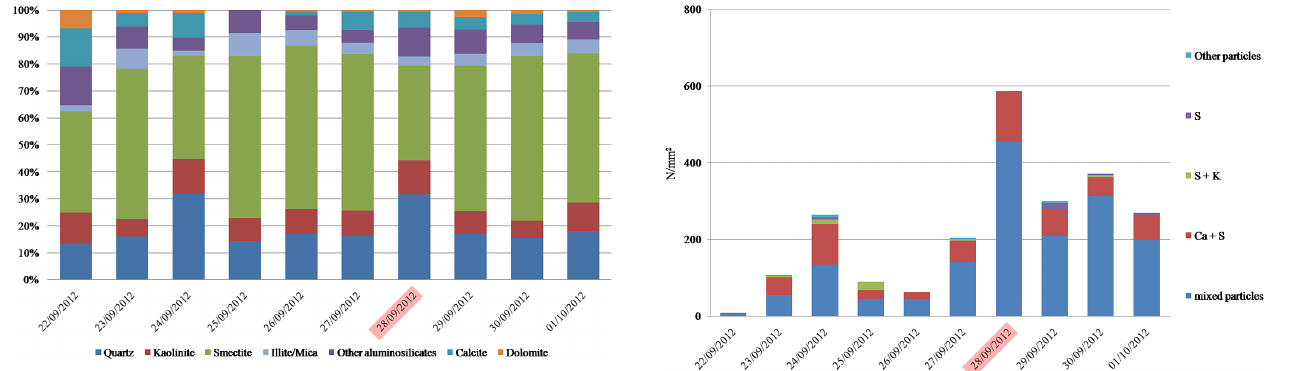
Figure 7. Surface concentration of several S-rich particulate com- ponents in the ≥ 0.7µm fraction. This particulate consists mainly of mixed particles with a composed origin and, subordinately, of gypsum. The flare event date is highlighted in